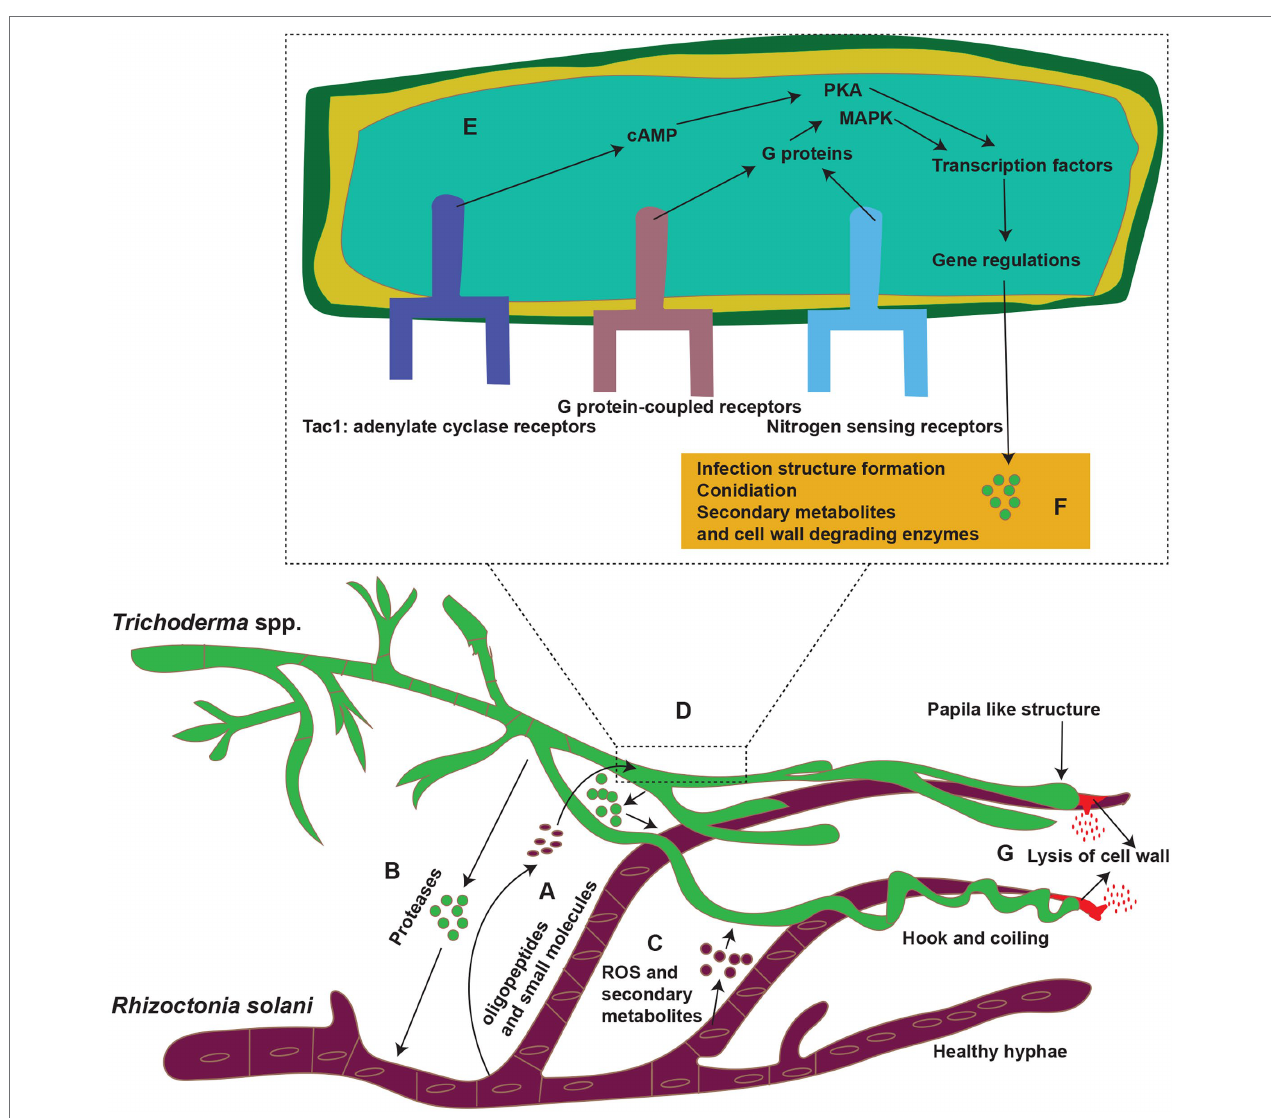
FIGURE 3 | Mycoparasitism; Trichoderma spp. (Green color) parasitize R. solani (purple) in soil. (A–C) Trichoderma spp. recognized R. solani by tiny molecules (oligopeptides and small other molecules); some of these molecules are peptides released by the action of proteases of Trichoderma spp. prior to contact. Also R. solani secrete ROS and secondary metabolites in response to Trichoderma spp. (D) These molecules bind to G protein-coupled receptors (GPCRs; such as Gpr1 ) or nitrogen-sensing receptors (Target of rapamycin; TOR pathway), or adenylate cyclase receptors on the surface of Trichoderma spp. hyphae. (E) After binding to the receptors, the molecules induce a signaling cascade involving G proteins and mitogen-activated protein kinases (MAPKs) or protein kinases (PKA), which then modulate the activities of transcription factors (TFs) and gene regulations. (F,G) These substances then boost the expression of genes that code for enzymes involved in secondary metabolite production and lysis of the cell wall of R. solani . Reconstructed from Druzhinina et al.